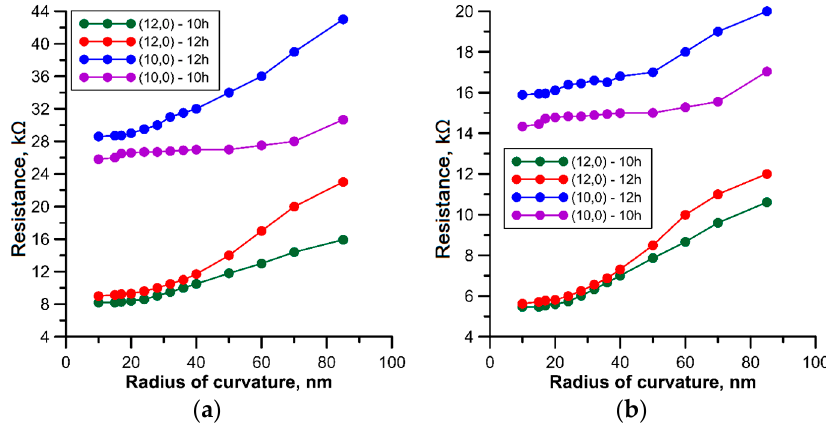
Figure 8. Plot of changes in electrical resistance during bending of graphene–CNT composite films along the CNT axis (in the Y -direction): ( a ) monolayer films; ( b ) bilayer films.